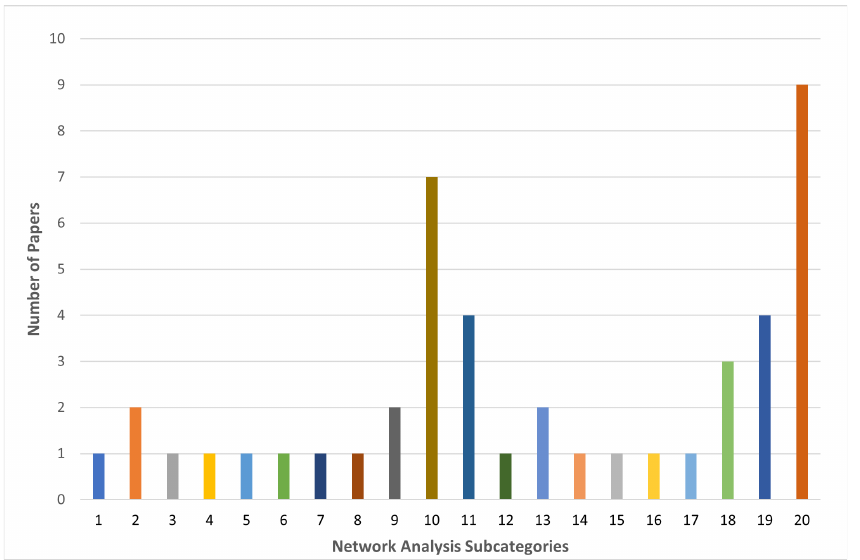
Figure 4. A snapshot of different themes discussed regarding network analysis of dark net privacy and security discussed in the papers.